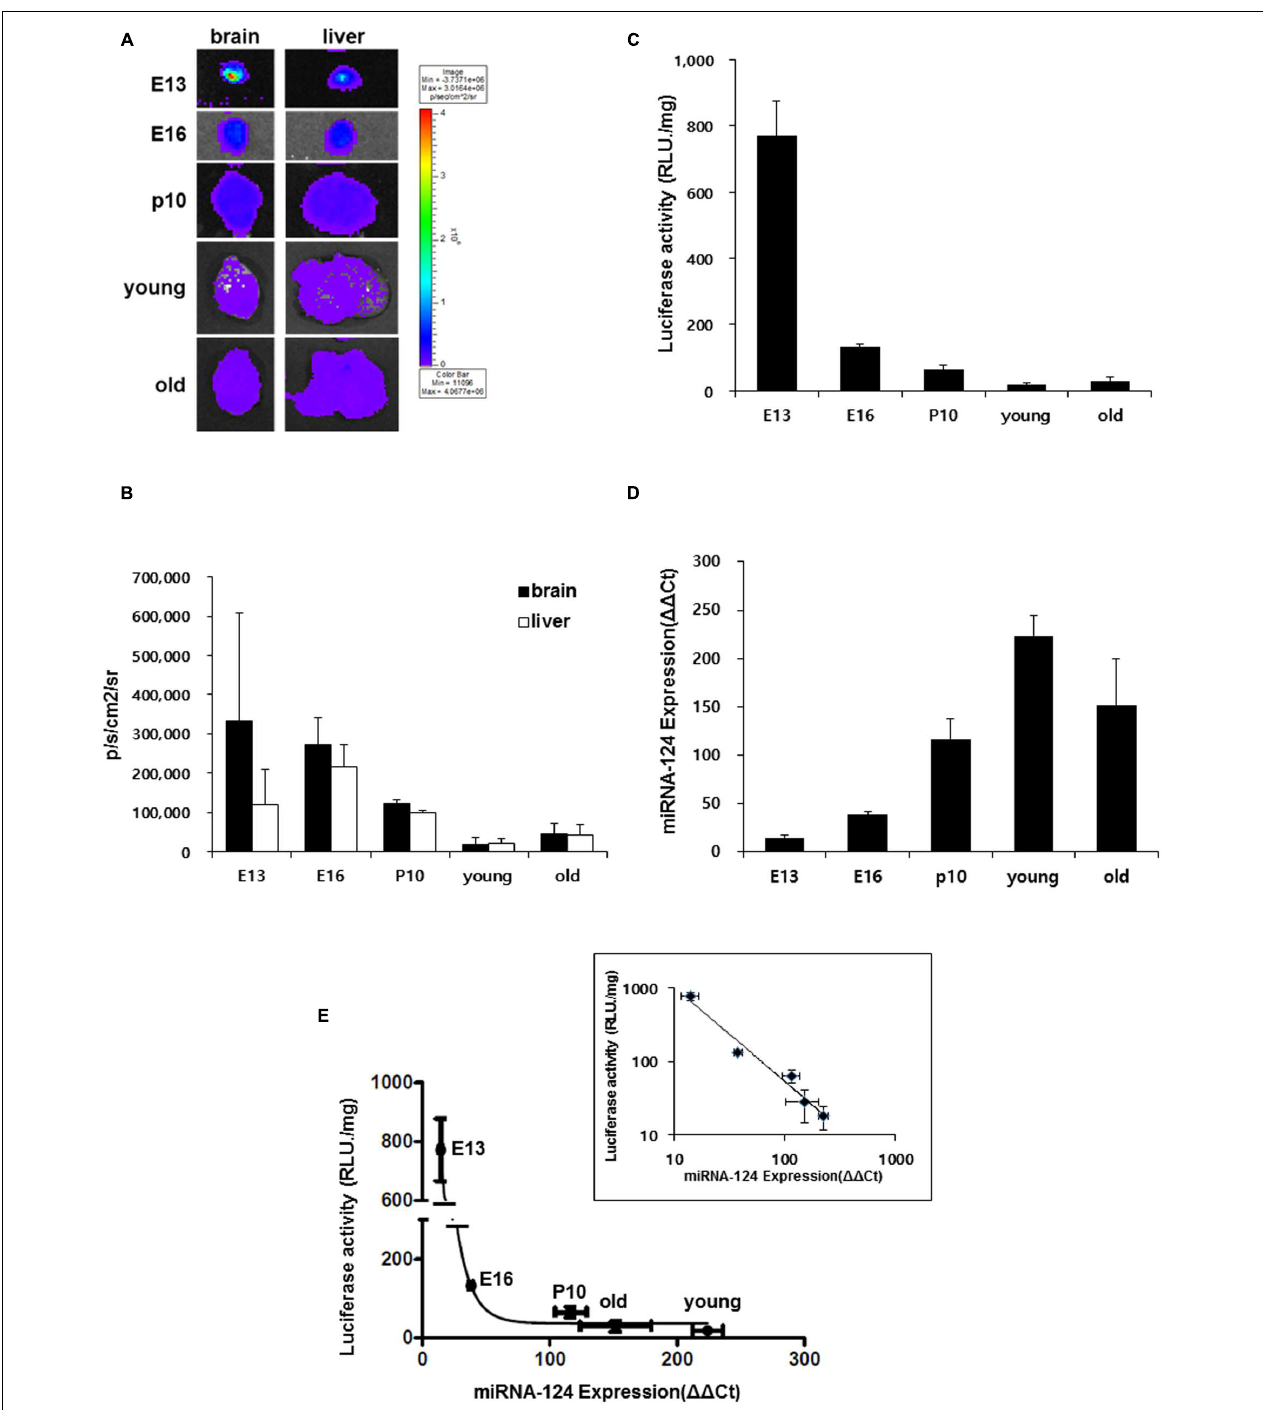
FIGURE 4 | Developmental stage-dependent miR-124 expression regulates luciferase signal. (A) Ex vivo bioluminescence images of brain and liver of a transgenic mouse along the bodily development in utero and after birth (E13 n = 6, E16 n = 6, P10 n = 3, young n = 3, and old n = 4); 3 ∼ 5 month old (young), 16 ∼ 24 month old (old). (B) Quantified results of these ex vivo images. Average counts of the brain and the liver was shown as photons/sec/cm2. The brain luciferase was maximal at E13 and decreased to the minimum at young adult period and the liver luciferase was maximal at E16 and minimum at young adult period. (C) Luciferase activity (RLU/mg) of brain lysate in each developmental stage. (D) Quantitative real-time RT-PCR results of mir-124 over U6 of the brain lysates in each developmental stage. Data are shown as means ± SD. RLU/mg means relative light units per mg of protein of the lysate. (E) Relationship between miR-124 expression and luciferase activity of brain lysates which showed inverse relation. After log-log transform, the relation was inverse-proportional (inset). Whisker of each point represents S.D.’s of miR-124 expression (abscissa) and luciferase activity (ordinate).